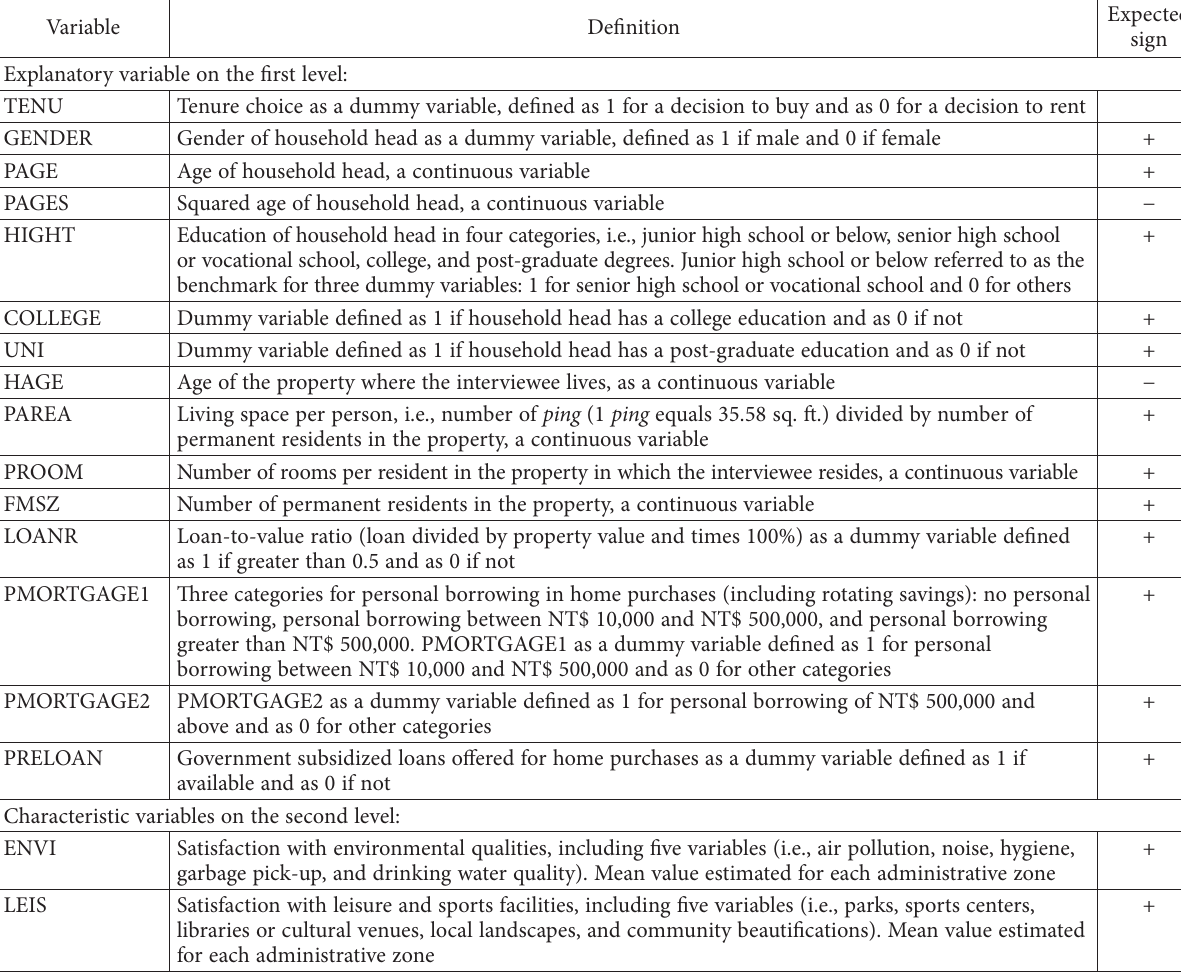
Table 1. Variable selections and